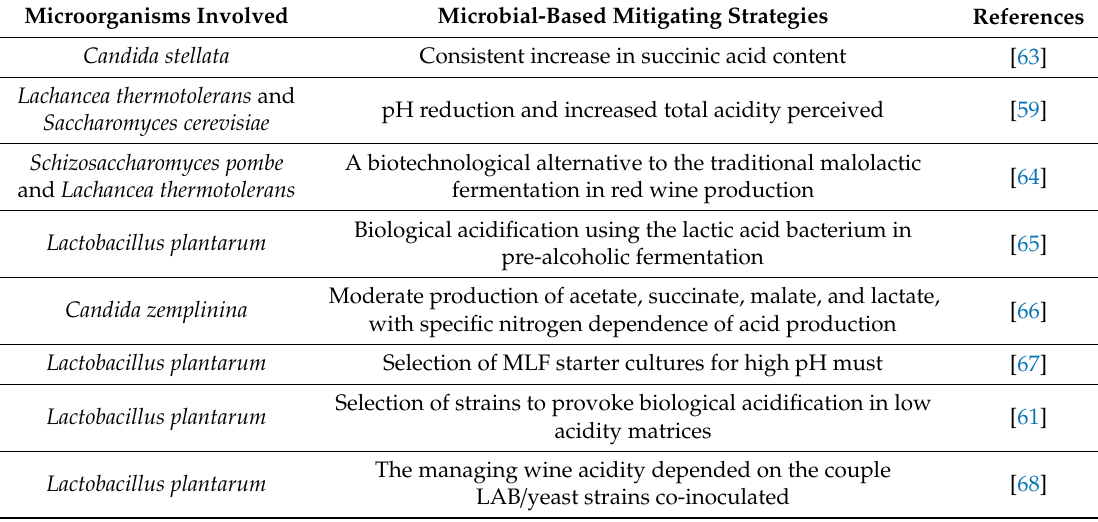
Table 4. A list of studies that propose microbial-based solutions that can have potential applications in mitigating the reduced content in organic acids and an increased pH. Microorganisms